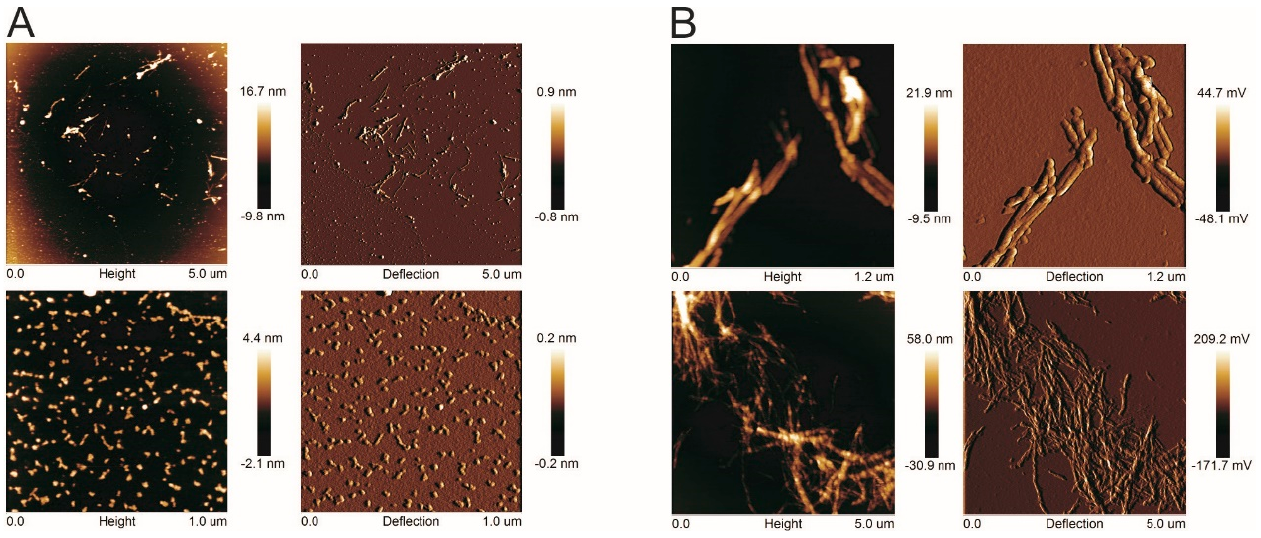
Figure 1. AFM images of stefin B fibrils. AFM images of stefin B fibrils at pH 4.8, room temperature, and 9% TFE ( A ); and pH 7.5, 50 °C, 9% TFE ( B ) are shown at two different magnifications for each sample. For each AFM measurement, height and deflection are shown. Adapted from [25].